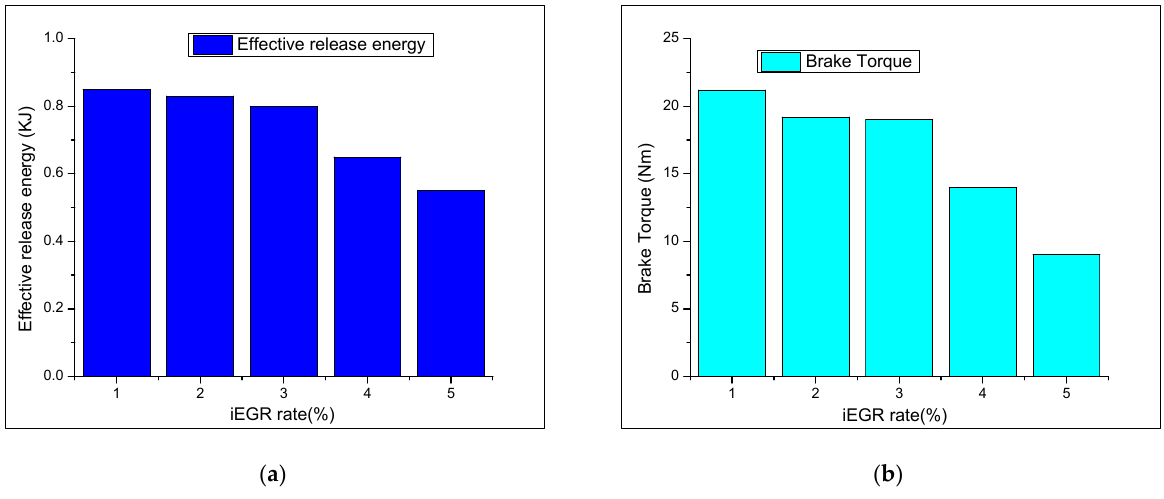
Figure 15. The effect of iEGR on ( a ) Effective release energy; ( b ) brake torque. The increase in iEGR led to a decrease in the heat release rate and effective release energy, so the decrease in engine torque is a result (Figure 15b).